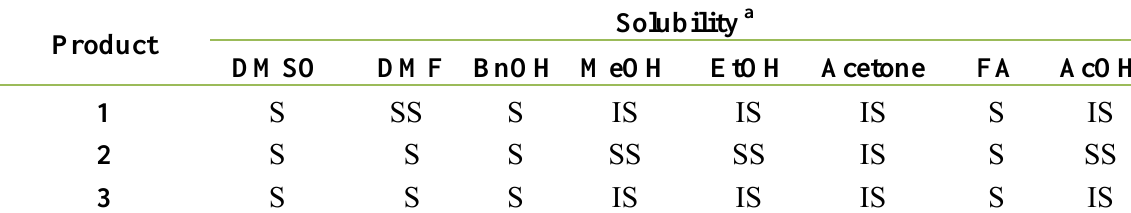
Table 2. Solubility of chitin benzoic acid esters in selected organic solvents. a